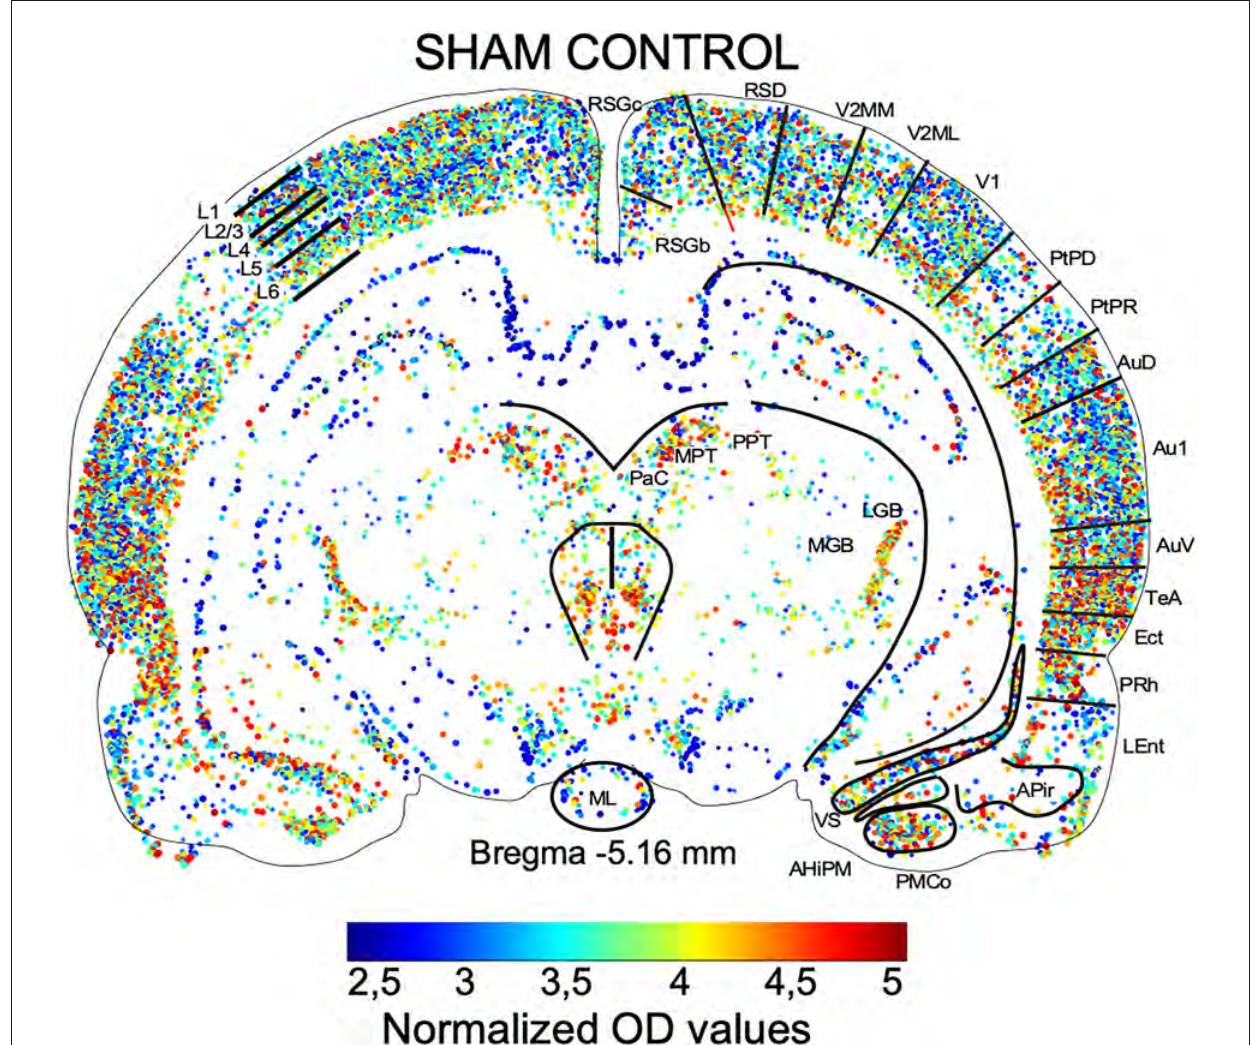
FIGURE2 Brain map after MATLAB reconstruction from segmented c-Fos immunostained sections. The lines and cytoarchitectonic subdivisions are modified from Paxinos and Watson’s rat brain atlas (Paxinos and Watson, 1998). Superimposing the atlas and the MATLAB map at the Bregma -5.16 mm section with cytoarchitectonic subdivisions of the cortex and brain stem nuclei highlights topographical differences in the distribution of dots and colors (normalized OD values). L- cortical layers. Abbreviations of cytoarchitectonic subdivisions follow the nomenclature of the Paxinos and Watson’s rat brain atlas (Paxinos and Watson,